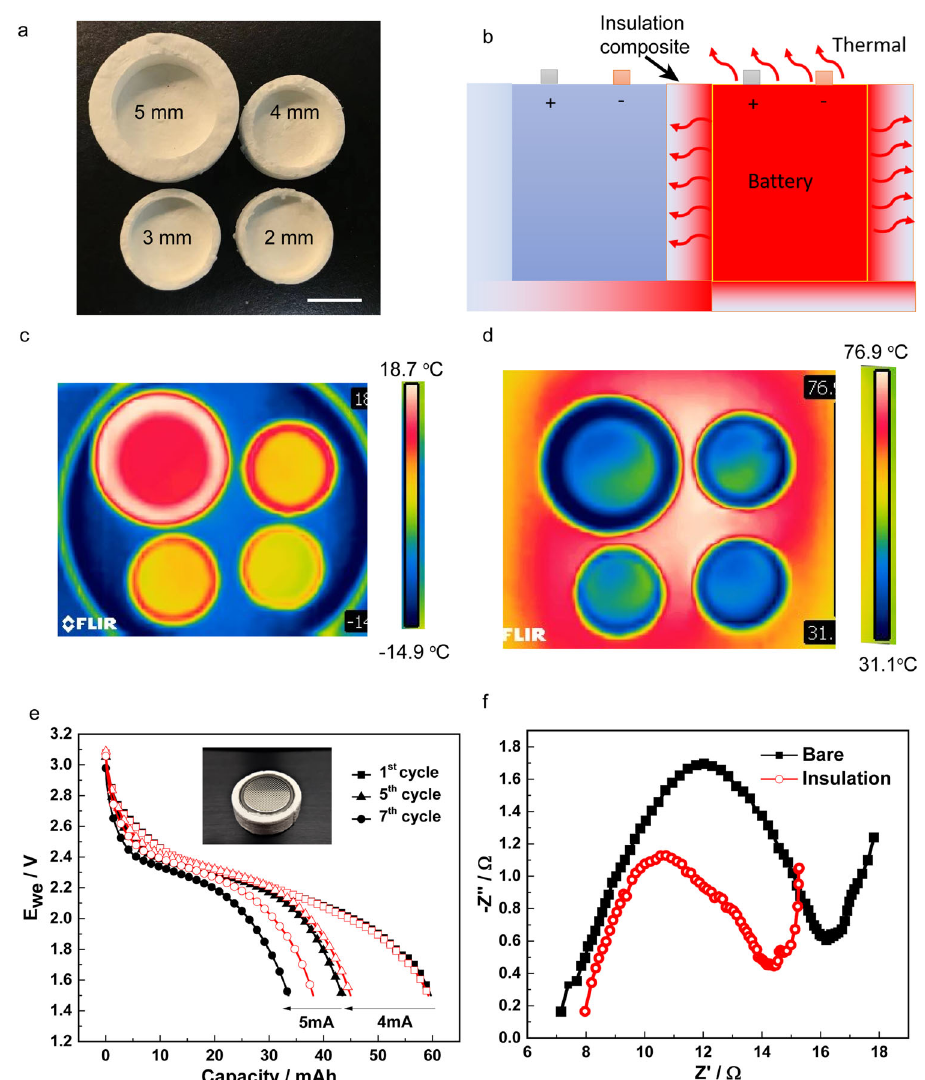
Fig. 4 | Additive manufacturing silivoxels for battery thermal management. a The DIW-silivoxels batterycases with thickness of 2mm,3mm,4mm, and 5mm. Scalebaris 10mm. b Thermalmitigation scheme of batterypacks. c , d IR imageof theDIW-silivoxelscaseswithdifferentthicknessesonacoldsurface( − 14.9°C)anda